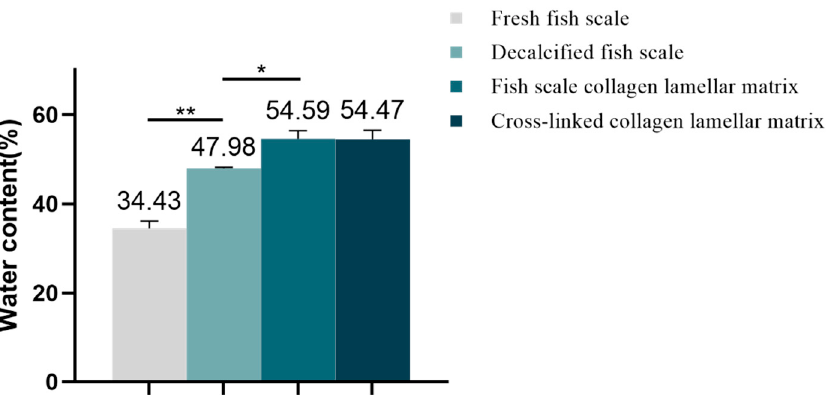
Figure 5. Water content of different samples ( n = 3). * p < 0.05; ** p < 0.01.